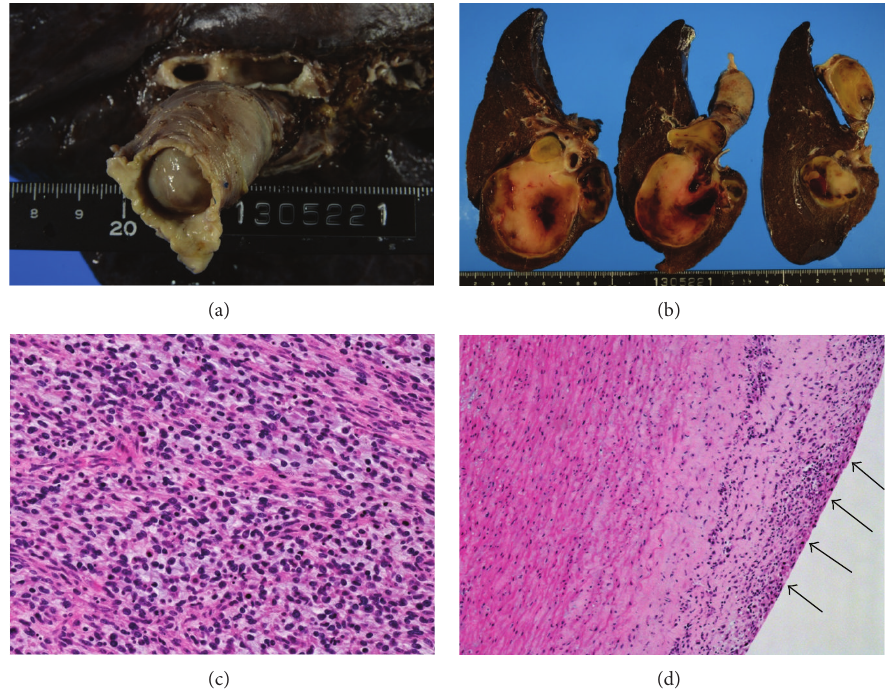
Figure 3: (a) Gross finding showed the obstruction of the right main pulmonary artery by tumor tissue. (b) Transverse sections revealed a massive invasion of the tumor into the adjacent pulmonary parenchyma. (c) Histologically, tumor was consisting of spindle or polygonal- shaped atypical cell with high mitotic activity, compatible with intimal sarcoma. (d) At the margin of the left main pulmonary artery, pleomorphic tumor cells proliferated in the vascular intima